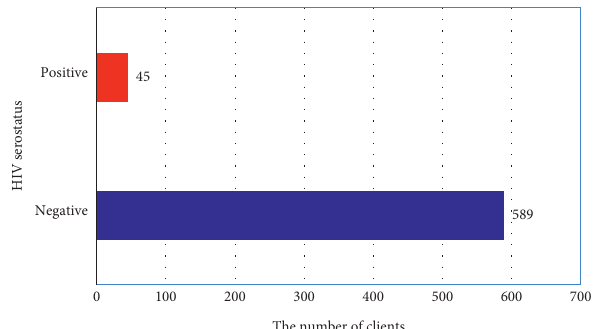
Figure 1: The overall HIV serostatus among pregnant mothers on ANC follow-up at